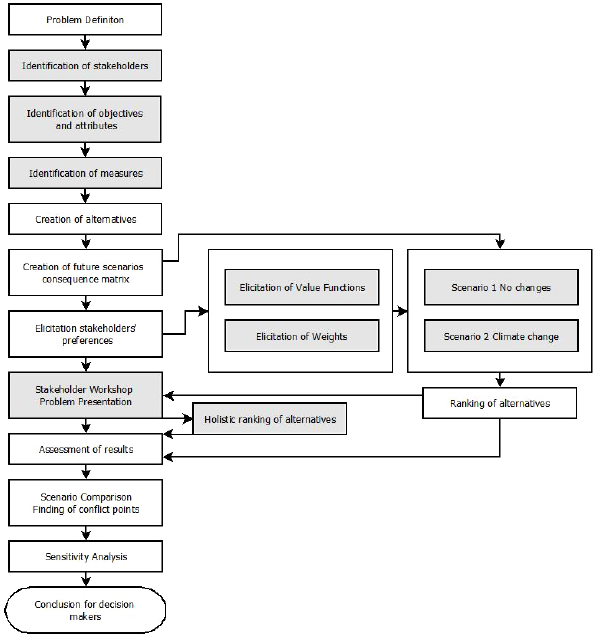
Figure 1. Method of evaluation of alternatives: grey charts indicate parts with stakeholder involvement.